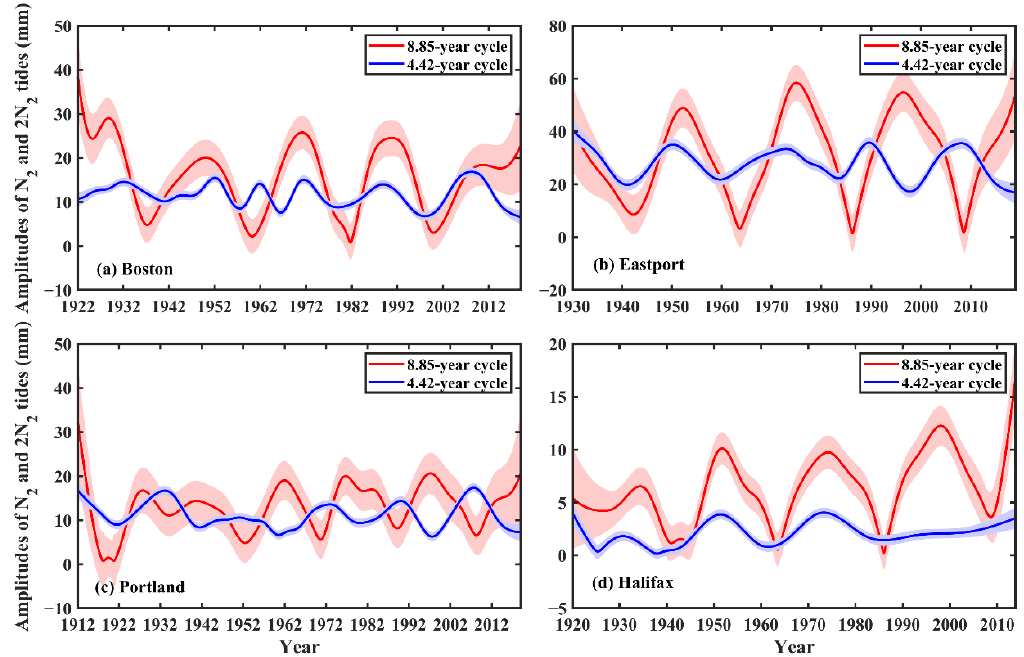
Figure 8. The 95% confidence interval for the 8.85-year cycle amplitudes of N 2 tide (red shadows) and 4.42-year cycle amplitudes of 2N 2 tide (blue shadows) at four stations. The solid lines represent the variations in amplitude (mm).